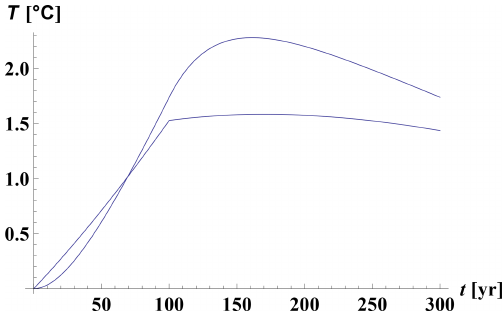
Figure 9. The auxiliary function h ( x ), which links the slow timescale of the two-box model and the timescale of the one-box model.